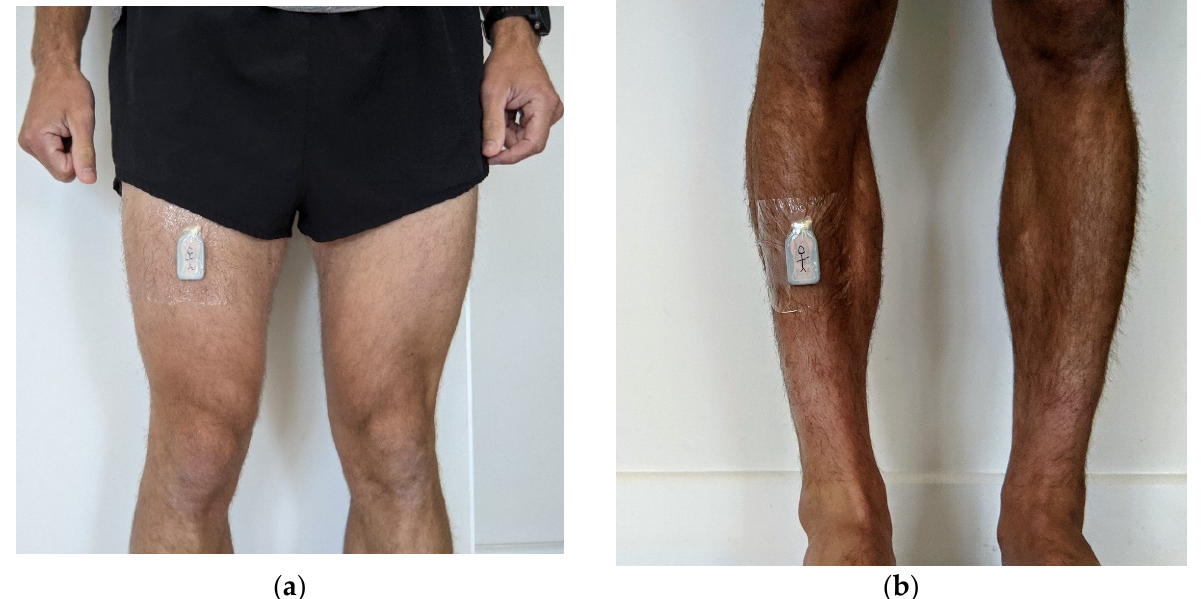
Figure 1. Experiment setup for activPAL PAL 3 in both positions: ( a ) thigh worn PAL3 for measuring postures; ( b ) shank worn PAL3 for measuring 3-axis accelerations.